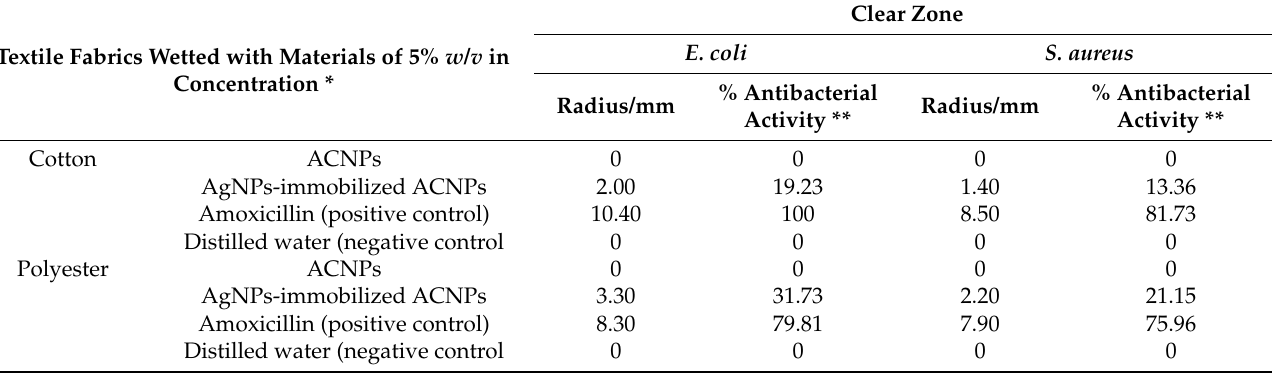
Table 2. Summary of the clear zone generated around the textile fabric disks, which wetted with the stated materials and positioned on E. coli and S. aureus’s bacterial culture.